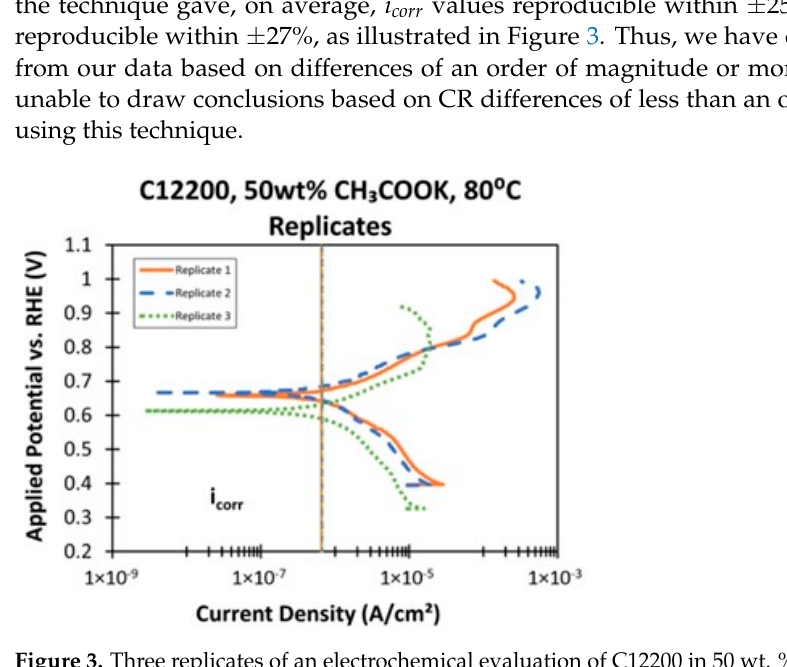
Figure 3. Three replicates of an electrochemical evaluation of C12200 in 50 wt. % CH 3 COOK at 80 °C, illustrating good reproducibility of i corr and corrosion behavior in the Tafel region.